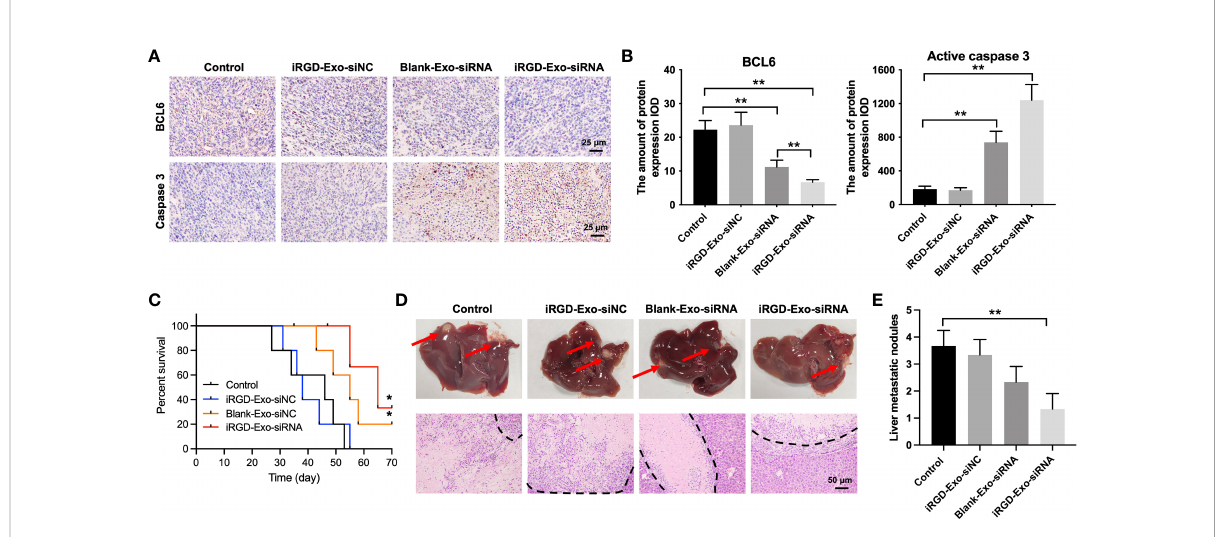
FIGURE 7 Tissue analyses. (A, B) IHC analysis of BCL6 and active caspase 3 expressions in tumor tissues collected from nude mice injected with OCI-Ly8 cells and exosomes via tail vein (Scale bar, 25 m m). IOD, integrated optical density. (C) The survival rate of mice are shown. (D, E) Representative images of tumor burdened liver tissues and their HE-stained sections. Red arrows, metastasis nodules in liver tissues. White section, tumor nodules. *P < 0.05, **P <